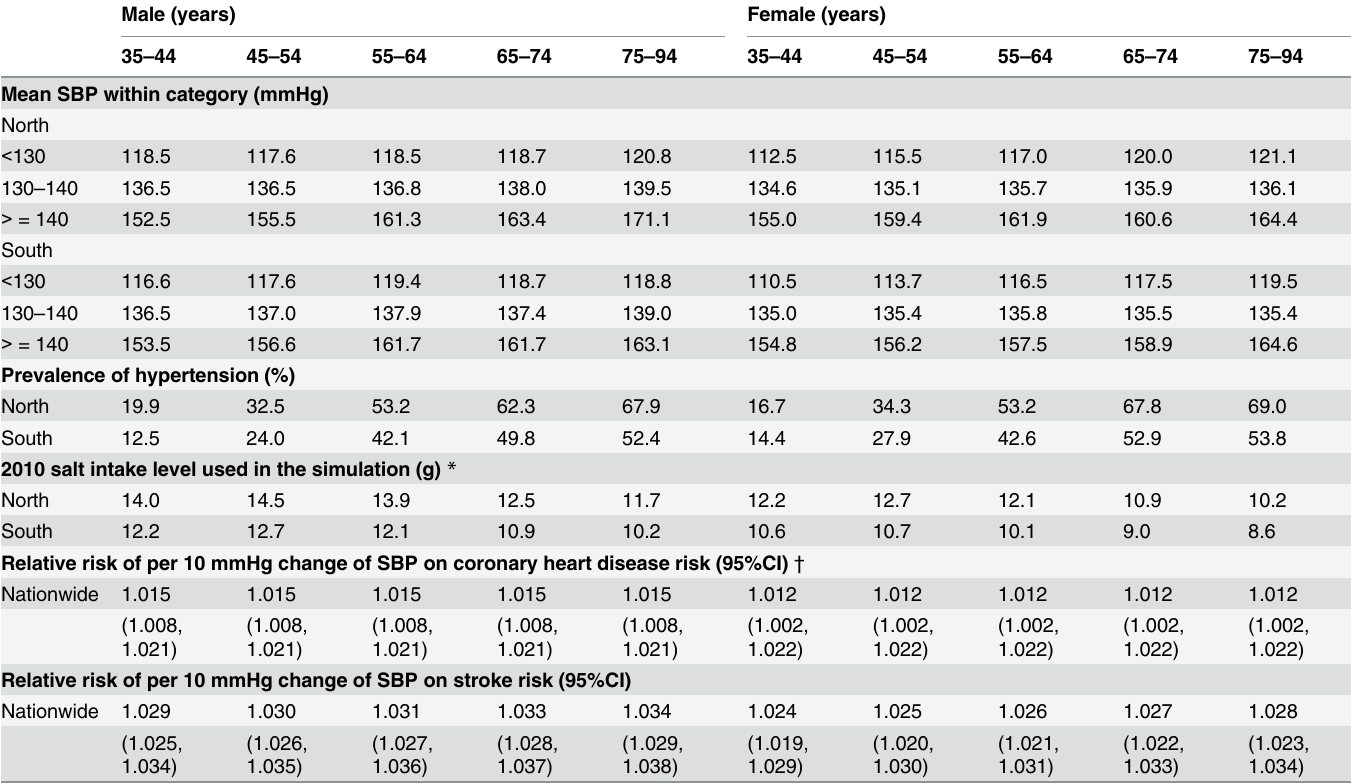
Table 1. Mean SBP levels, salt intake level, and relative risks of CVD associated with SBP changes within CVD Policy Model